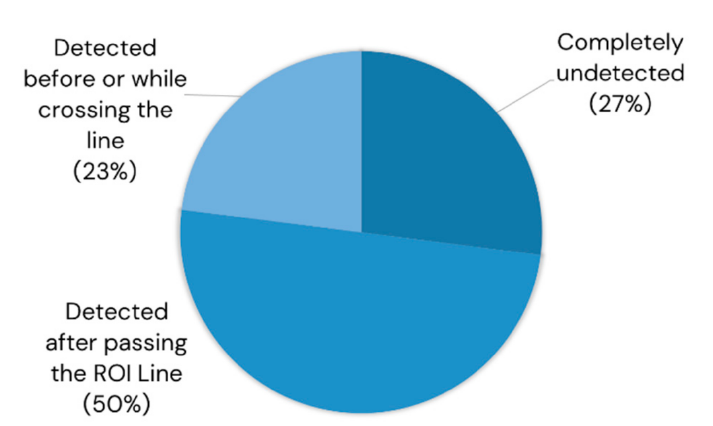
Figure 23. Breakdown of the false negative counts in the region-of-interest line-based counting